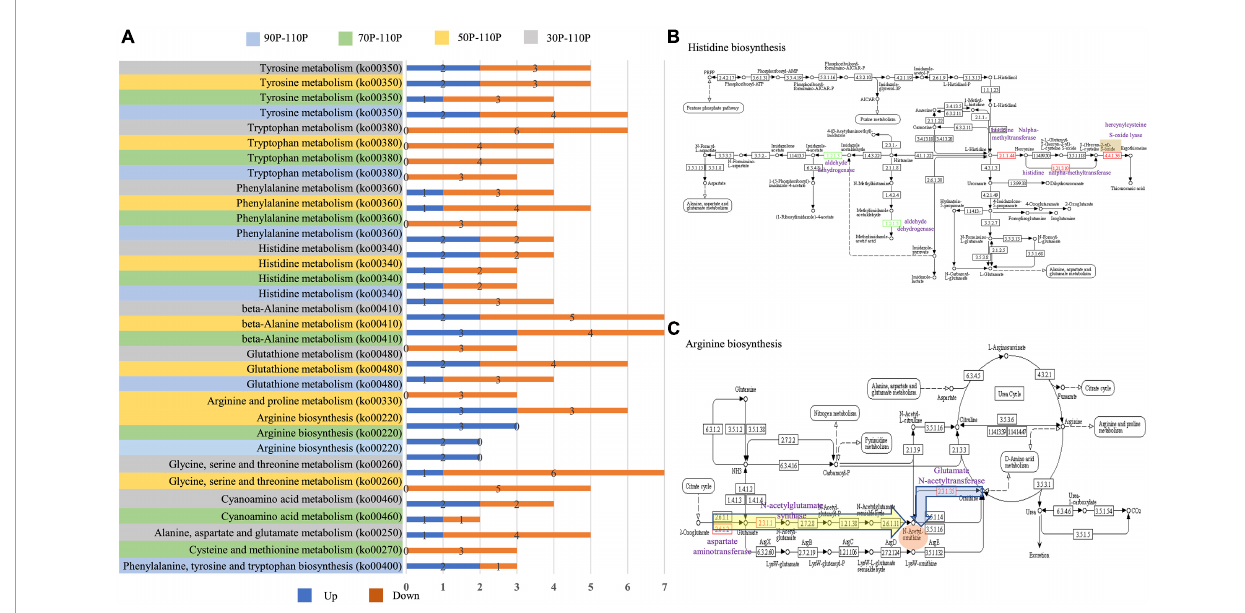
FIGURE5 Amino acid pathways of differentially expressed genes (DEGs) annotated by kyoto encyclopedia of genes and genomes (KEGG). (A) Significantly enriched amino acid pathways in the top 20 KEGG pathways. The up-regulated and down-regulated genes are shown by the blue and orange bar, respectively. The specific values are marked on the side. Amino acid metabolism pathway are displayed on the left: gray indicates 30P_110P; yellow 50P_110P; green 70P_110P and blue 90P_110P. (B) Histidine metabolism (http://www.kegg.jp/kegg-bin/show_pathway?map00340) identified by KEGG annotation. The down-regulated genes are shown in green, and up-regulated are shown in red. One specific up-regulated gene in 30P_110P is marked in orange. The names of DEGs are marked in purple. (C) Arginine metabolism (https://www.kegg.jp/kegg-bin/show_pathway?map00220) identified by KEGG annotation. DEGs identified in all three groups are marked in a yellow box, and one gene specifically identified in 50P_110P is marked in a blue box. The red box indicates the intermediate product, N-acetyl-ornithine. The names of DEGs are shown in purple.